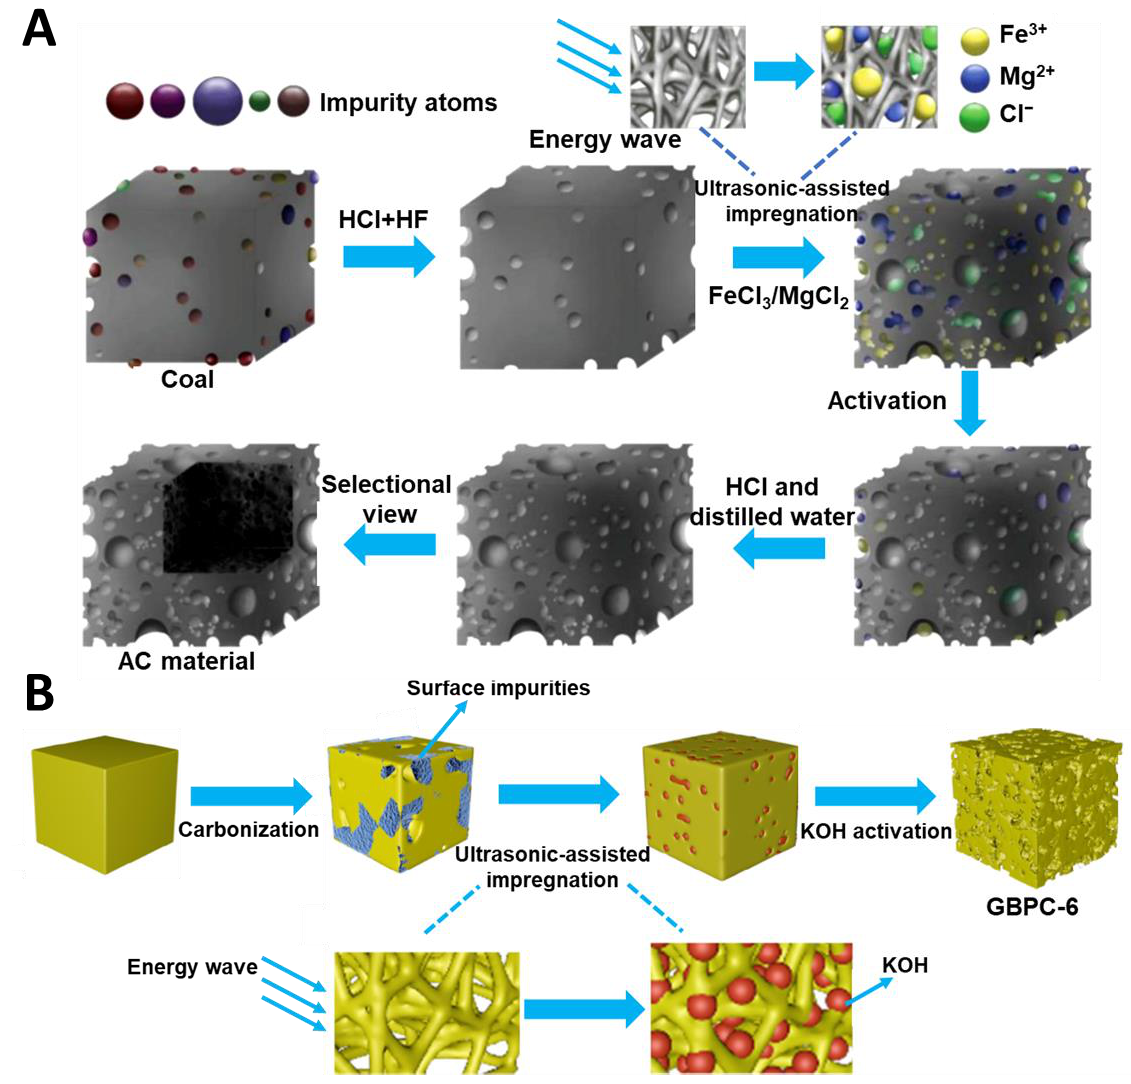
Figure 5. ( A ) Schematic illustration of activated carbon synthesis via ultrasound-assisted bimetallic activation strategy [75]. Reproduced with permission from ref. [75]. Copyright 2020, Elsevier